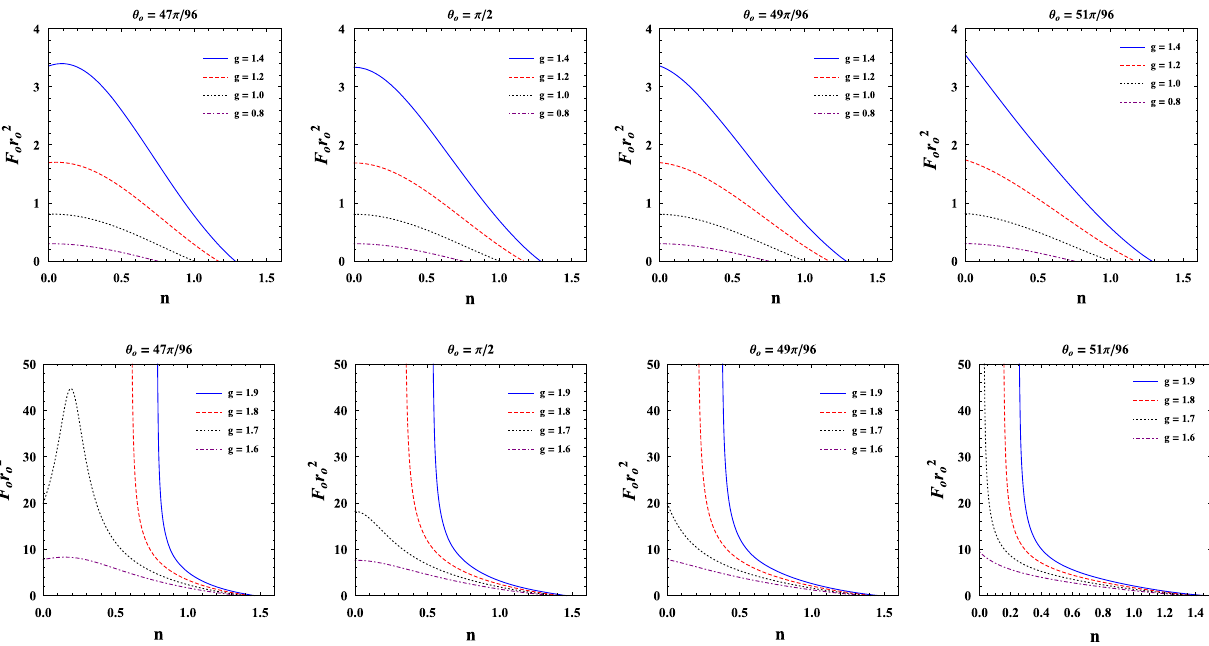
Fig. 5 The change of the flux F o at observer with the redshift factor g for different NUT charge n and the observer’s angular position θ o as the source lies in the NHEKTN line. Here, we set M = 1